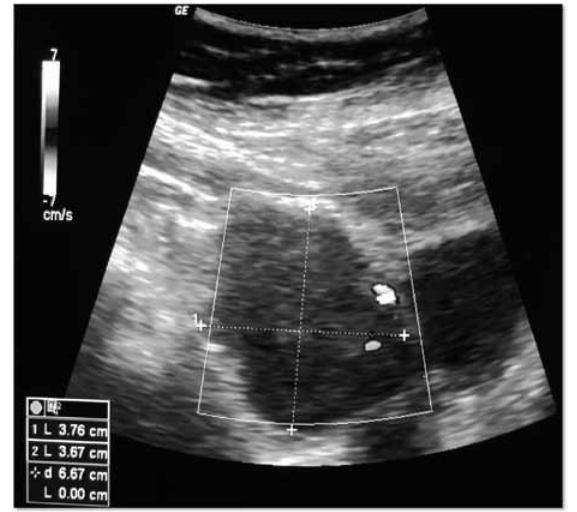
Figure 1 - Abdominal